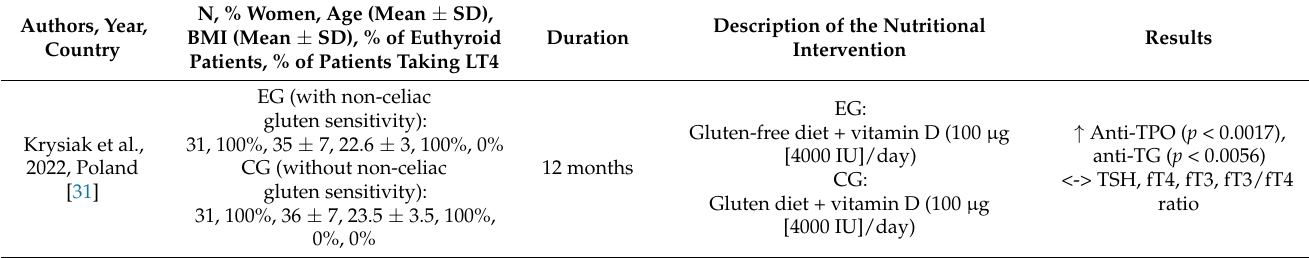
Table 2. The characteristics of the included studies, summary of dietary interventions, and clinico- pathologic